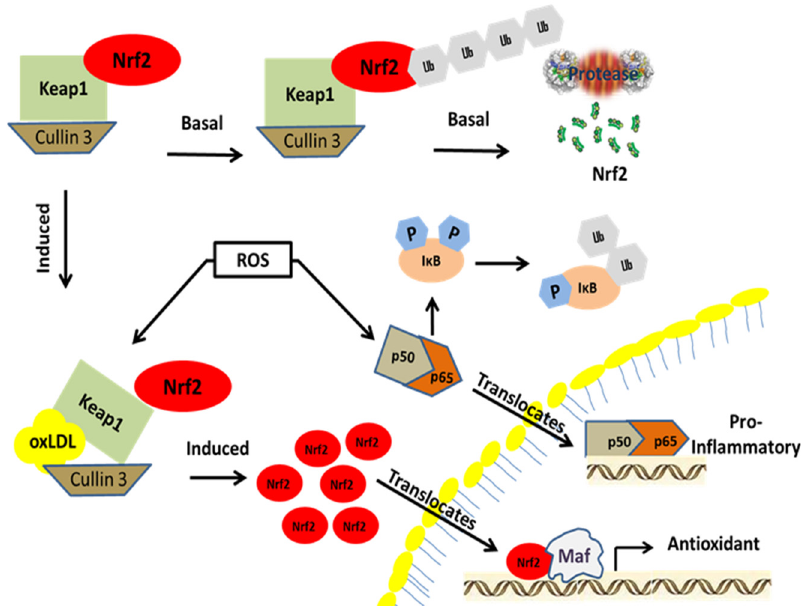
Figure 2. Nrf2 activation pathway. Nrf2 is a member of the bZIP family of